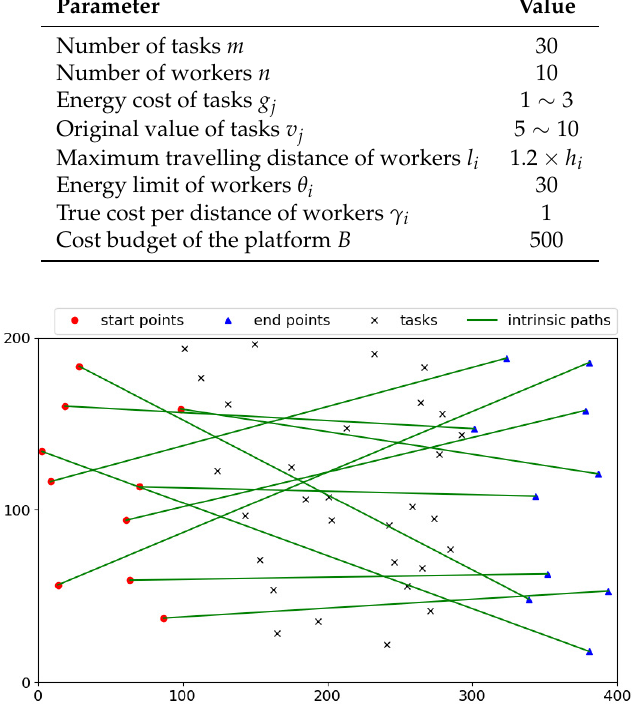
Figure 4. Simulation